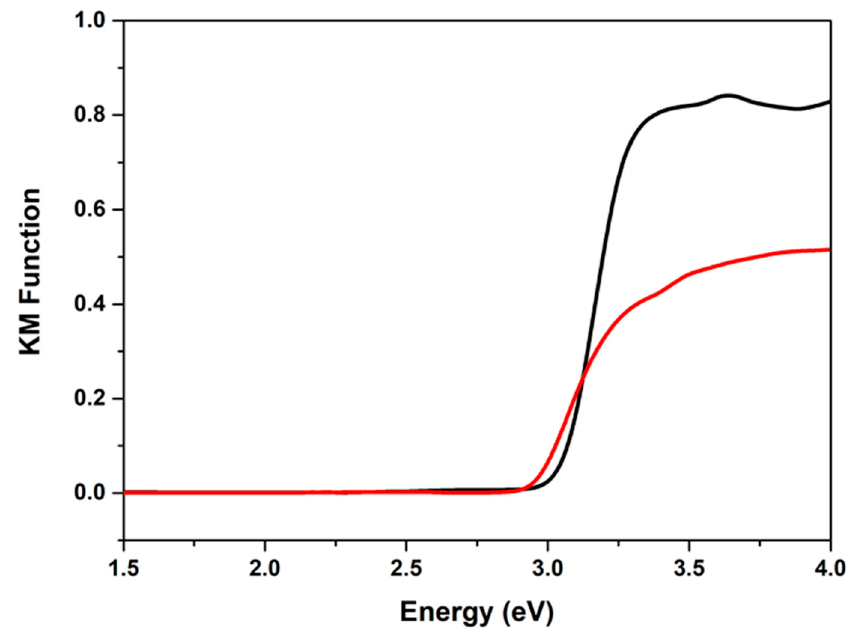
Figure 5. UV-vis absorption plots of 1 (black) and 2 (red). Figure 5. UV ‐ vis absorption plots of 1 (black) and 2 (red). Figure 5. UV ‐ vis absorption plots of 1 (black) and 2 (red).